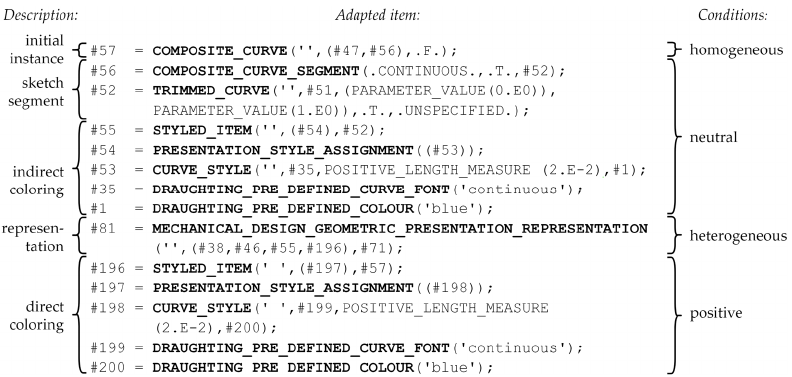
Figure 10. Adapted, compatible sketch coloring for an error-free import into Catia.